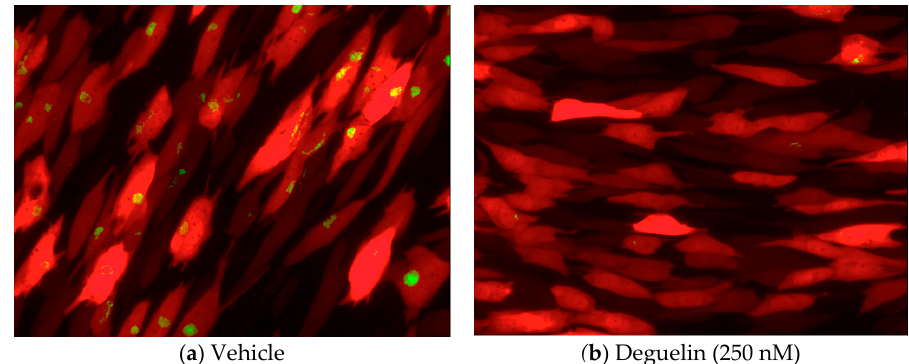
Figure 1. Deguelin significantly reduces the expression of late gene products in HCMV-infected NuFF-1 cells. NuFF-1 cells were infected with TB40/E mCherry -UL99eGFP (UL99eGFP; moi = 1.0) in the presence of ( a ) vehicle (DMSO) or ( b ) deguelin (250 nM) for 72 h. Red, mCherry (marker of infection); green, eGFP (pp28 expression).